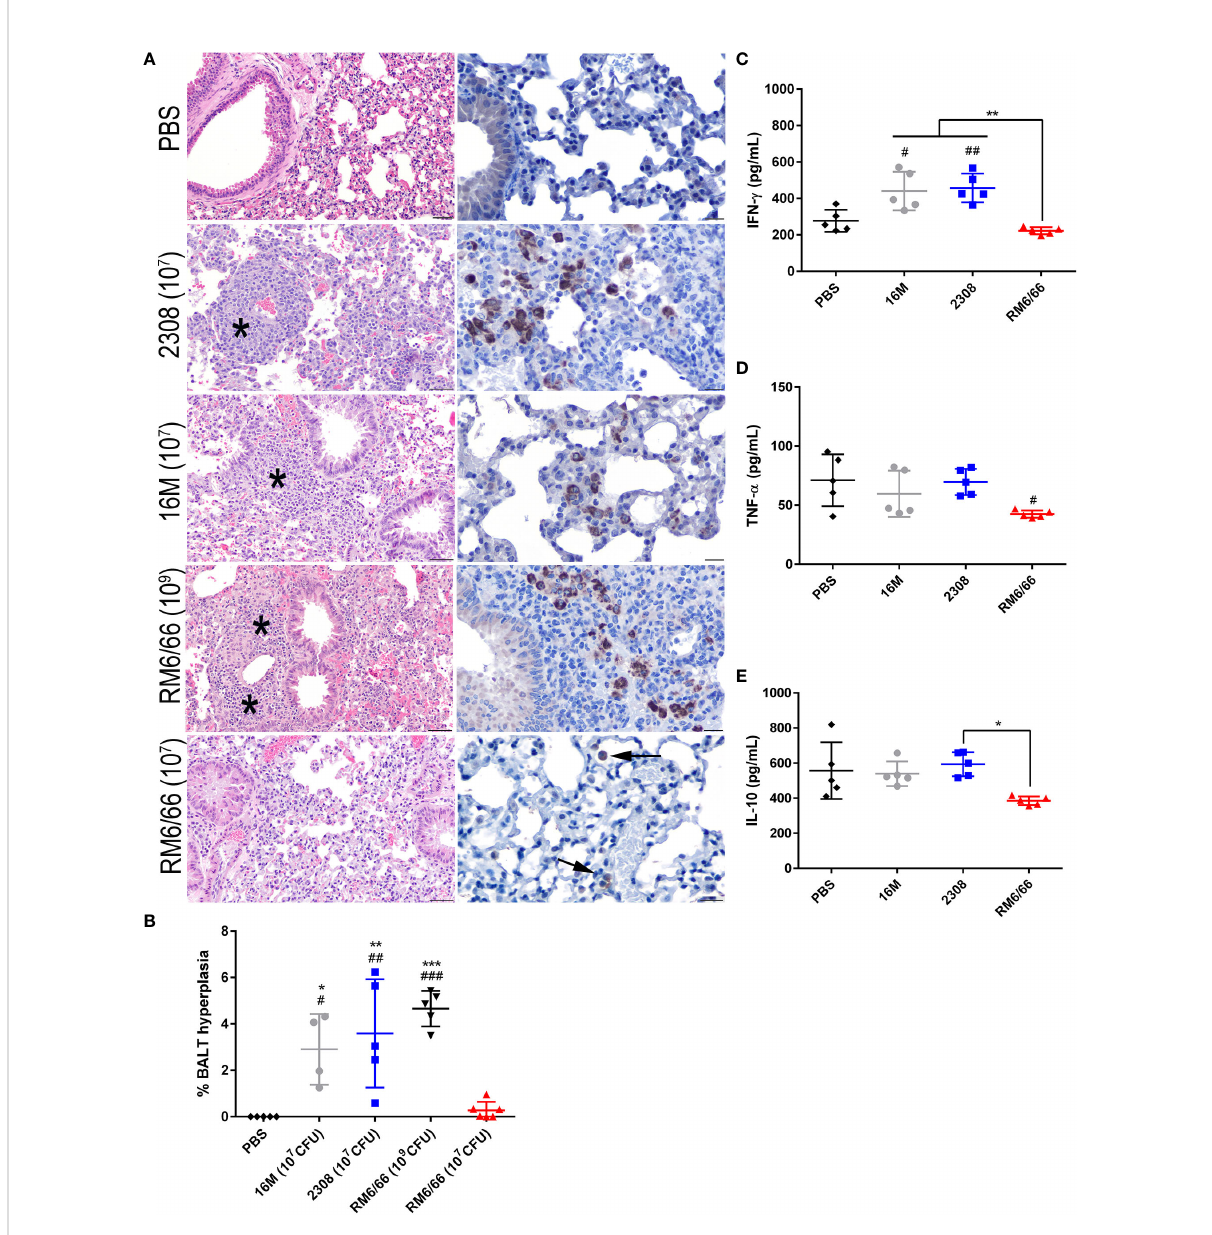
FIGURE 3 Intratracheal inoculation with B . abortus or B melitensis results in BALT hyperplasia in the lungs while B . canis only induces this change at a higher dose. (A) Representative histologic images of the lungs at 20x (left column, H&E stain, scale bar= 50 µm) from each group at 2-weeks post-infection showing thick accumulations of lymphocytes with fewer plasma cells and macrophages surrounding bronchioles (BALT hyperplasia, indicated by *) in mice inoculated with B . abortus, B. melitensis , or a high dose of B . canis . Brucella antigen was detected within the cytoplasm of macrophages by immunohistochemistry in infected animals (right column, IHC with DAB chromagen, 40x magni fi cation, scale bar= 20 µm). (B) Quanti fi cation of % BALT hyperplasia within the lung at 2-weeks post-inoculation. Measurement of cytokines in lung homogenate supernatants at 2-weeks post-infection, including (C) IFN- g , (D) TNF- a , and (E) IL-10. Data were analyzed using via one-way ANOVA and Tukey ’ s multiple comparisons test. Signi fi cant differences from B . canis 10 7 CFU are depicted (*p < 0.05, **p < 0.01, ***p < 0.001) and between infection groups and the PBS negative control group (#p < 0.05, ##p < 0.01, ###p <